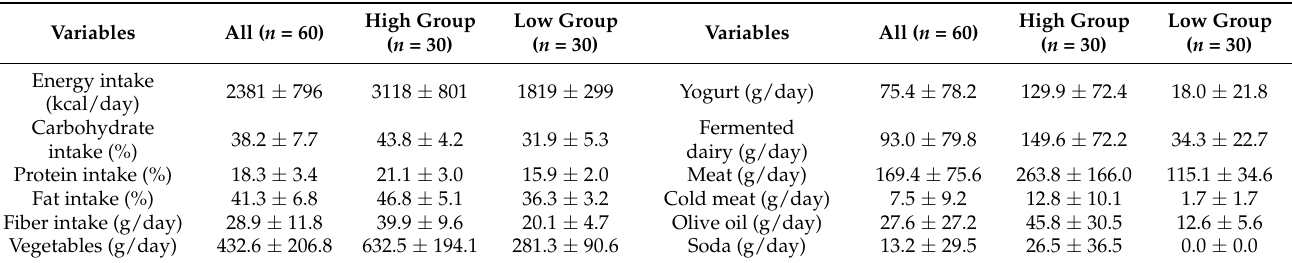
Table 2. Nutritional characteristics of the